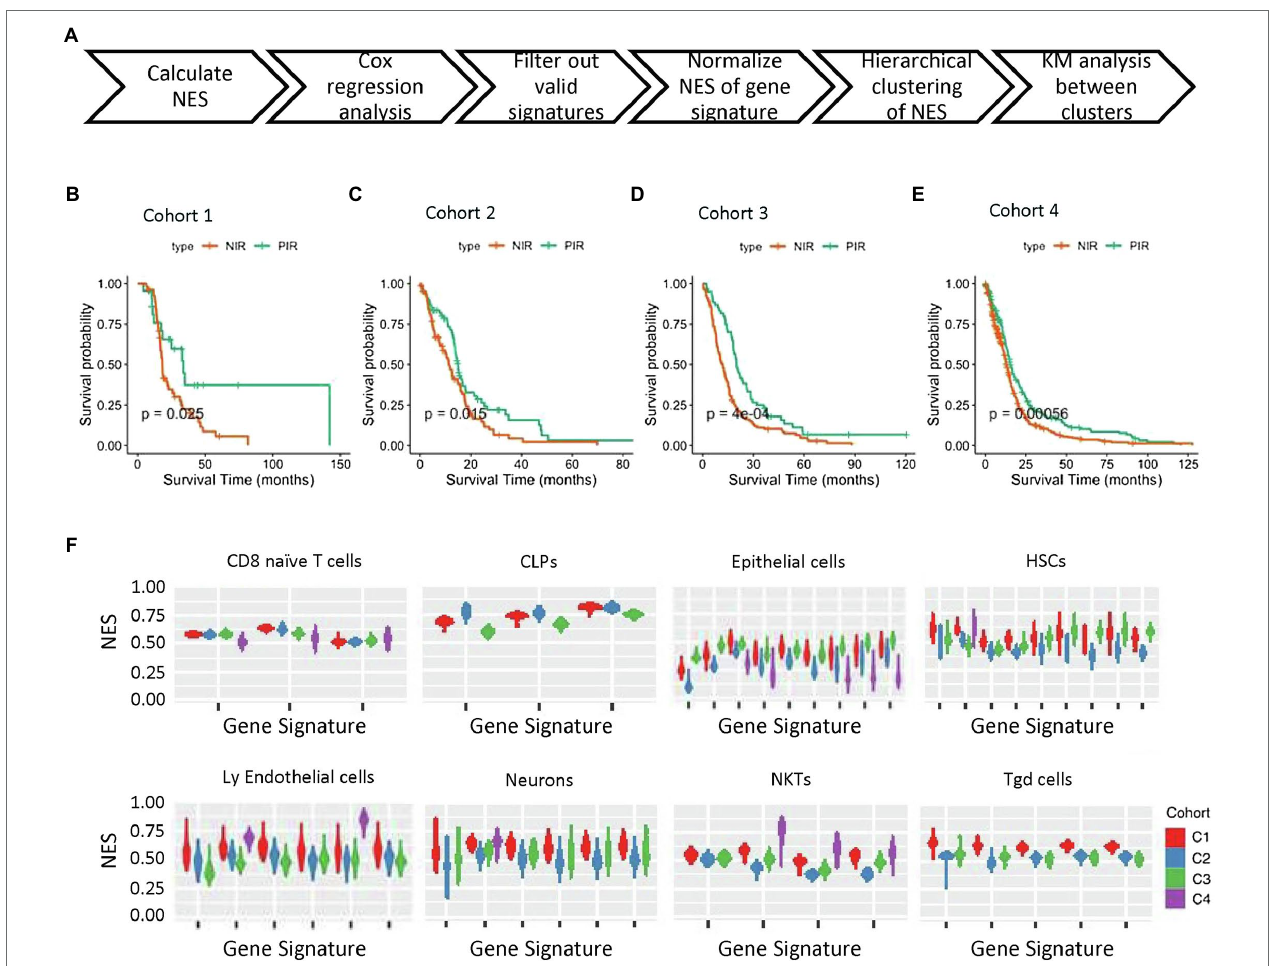
FIGURE 1 | NES-based stratification of patient survival. (A) Workflow of NES-based stratification and validation of survival time. (B–E) Kaplan–Meier survival curves of the NIR and PIR clusters in the four cohorts (PIR, orange; NIR, green). (F) NES distribution of four gene expression profiling cohorts of tumor tissues from GBM patients. Cell types and cohorts are noted. NES, normalized enrichment score; NIR, negative immune response; and PIR, positive immune